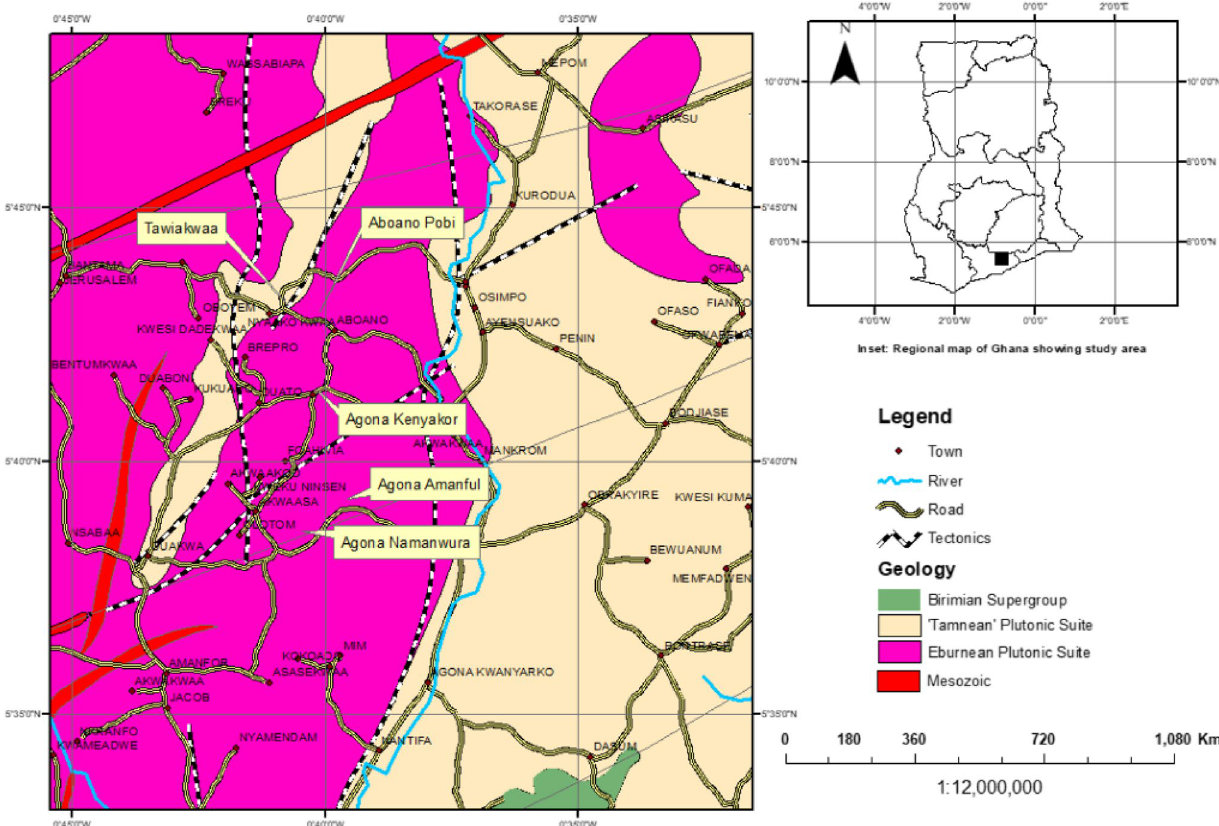
Fig. 1 Geological map of the study area (modified after GSD,